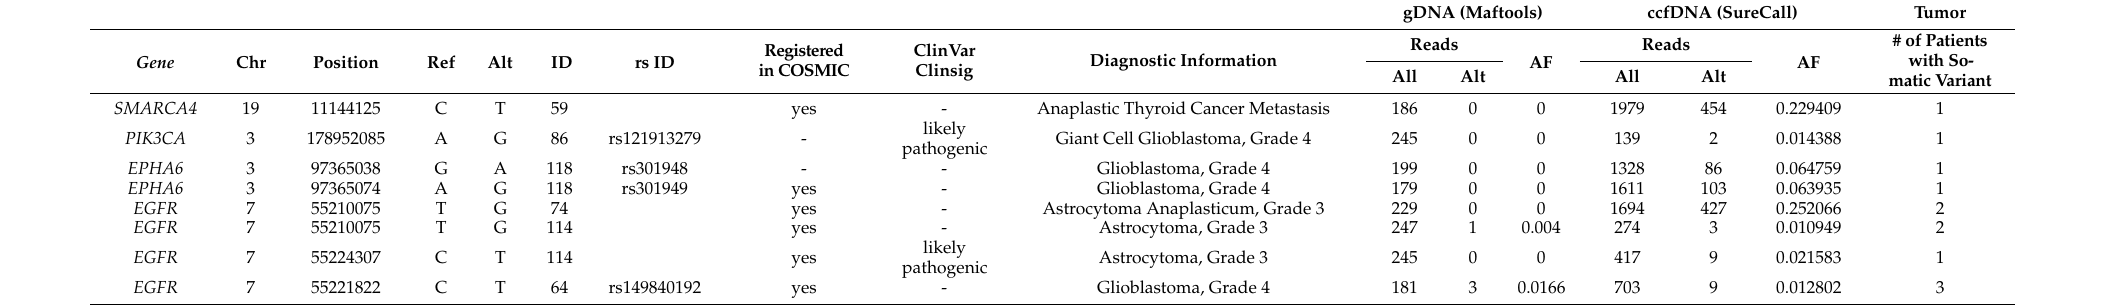
Table 4. Variants detected in ccfDNA, but not present in gDNA, confirmed as somatic in current study, tumor